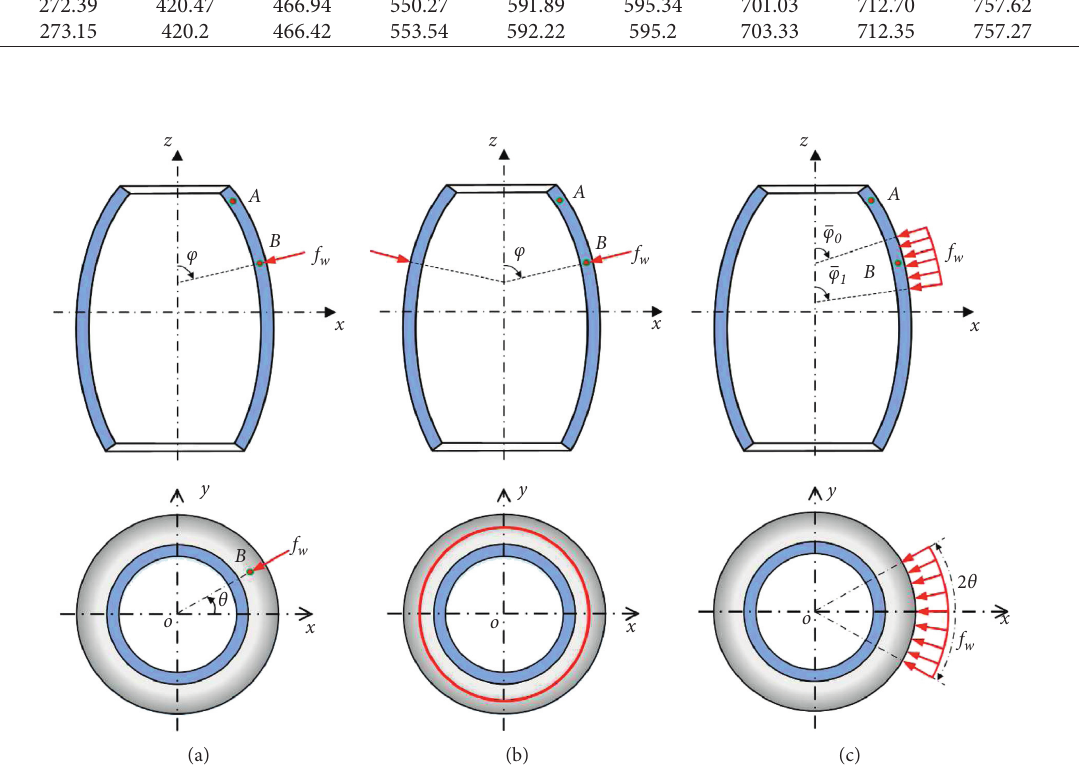
Figure 4: Schematic diagram of three categories of loads. (a) Point force. (b) Line force. (c) Surface